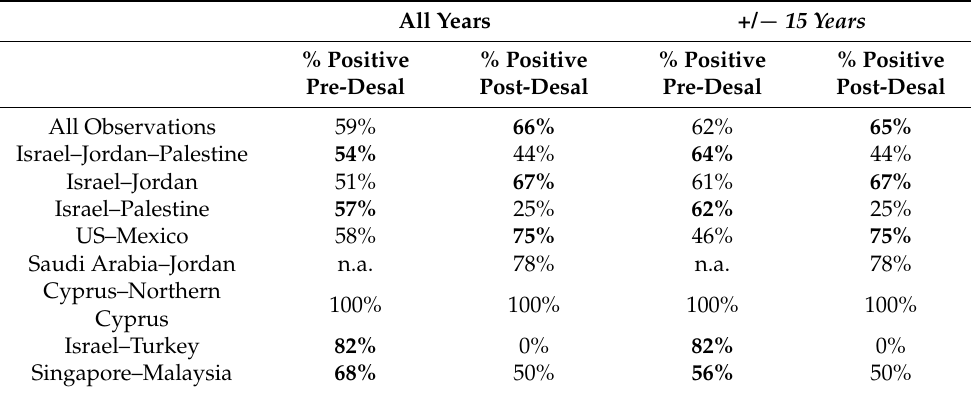
Table 2. Percent of Positive (Cooperative) Interactions Pre and Post-Desalination. All Years +/ − 15 Years % Positive % Positive % Positive % Positive Pre-Desal Post-Desal Pre-Desal Post-Desal All Observations 59% 66% 62%